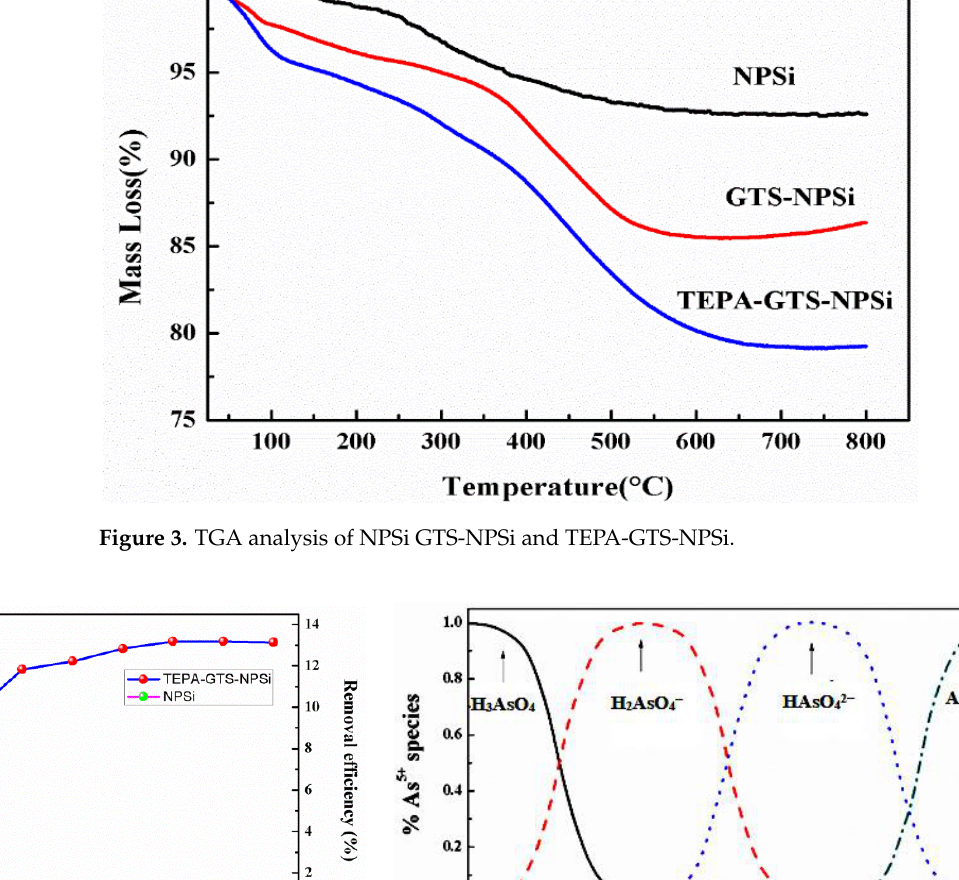
Figure 3. TGA analysis of NPSi GTS-NPSi and TEPA-GTS-NPSi.